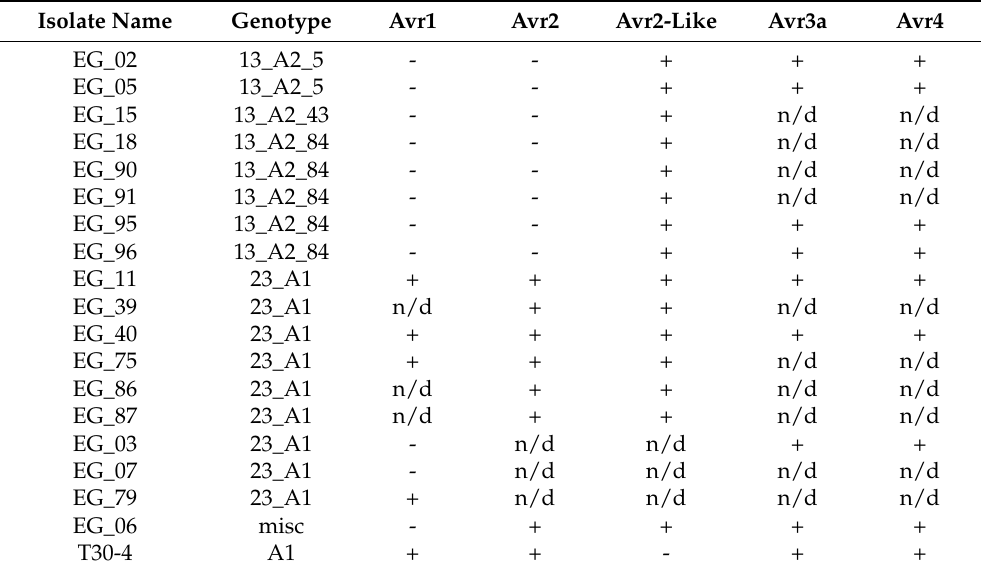
Figure 5. Genotype frequency of the Egyptian populations of P. infestans during the 3-year period 2010–2012. Genotype percentage frequency is represented in graph and numbers in table. Table 4. Screening for presence and absence effector genes in the selected P . infestans Egyptian